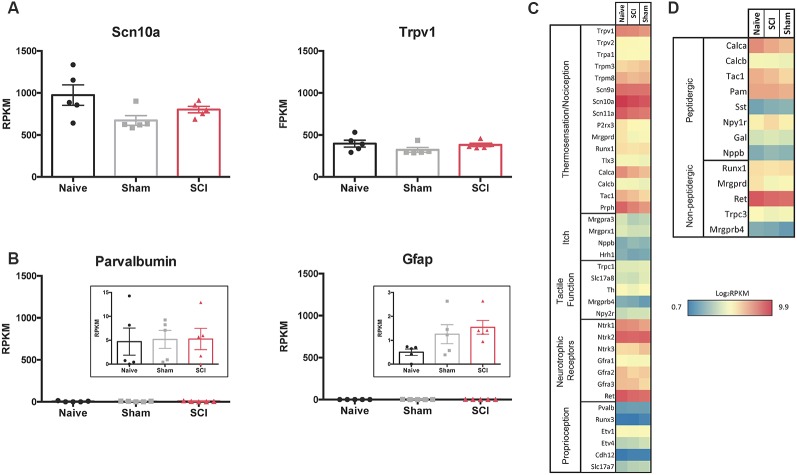
RNAseq demonstrates specificity of cell isolation. (A) Average RPKM values from RNAseq dataset from genes that are known to be highly expressed in the cell population of interest or (B) expected to be expressed in other cell populations outside of the one being studied; larger myelinated neurons or satellite glial cells, respectively, N = 5 per condition. (C) Heatmap of functional somatosensory mediators within the isolated cell population of interest. Genes were grouped based on roles established in the literature: thermosensation and nociception, itch, tactile function, and neurotrophic factors. (D) Heatmap of peptidergic and non-peptidergic markers. Graph: log2 of average RPKM values within each condition, RPKM >1, N = 5 per condition.